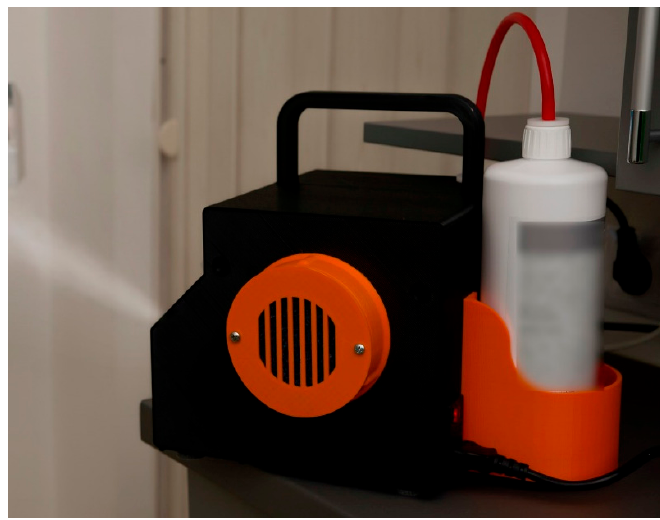
Figure 3. Fogging machine.